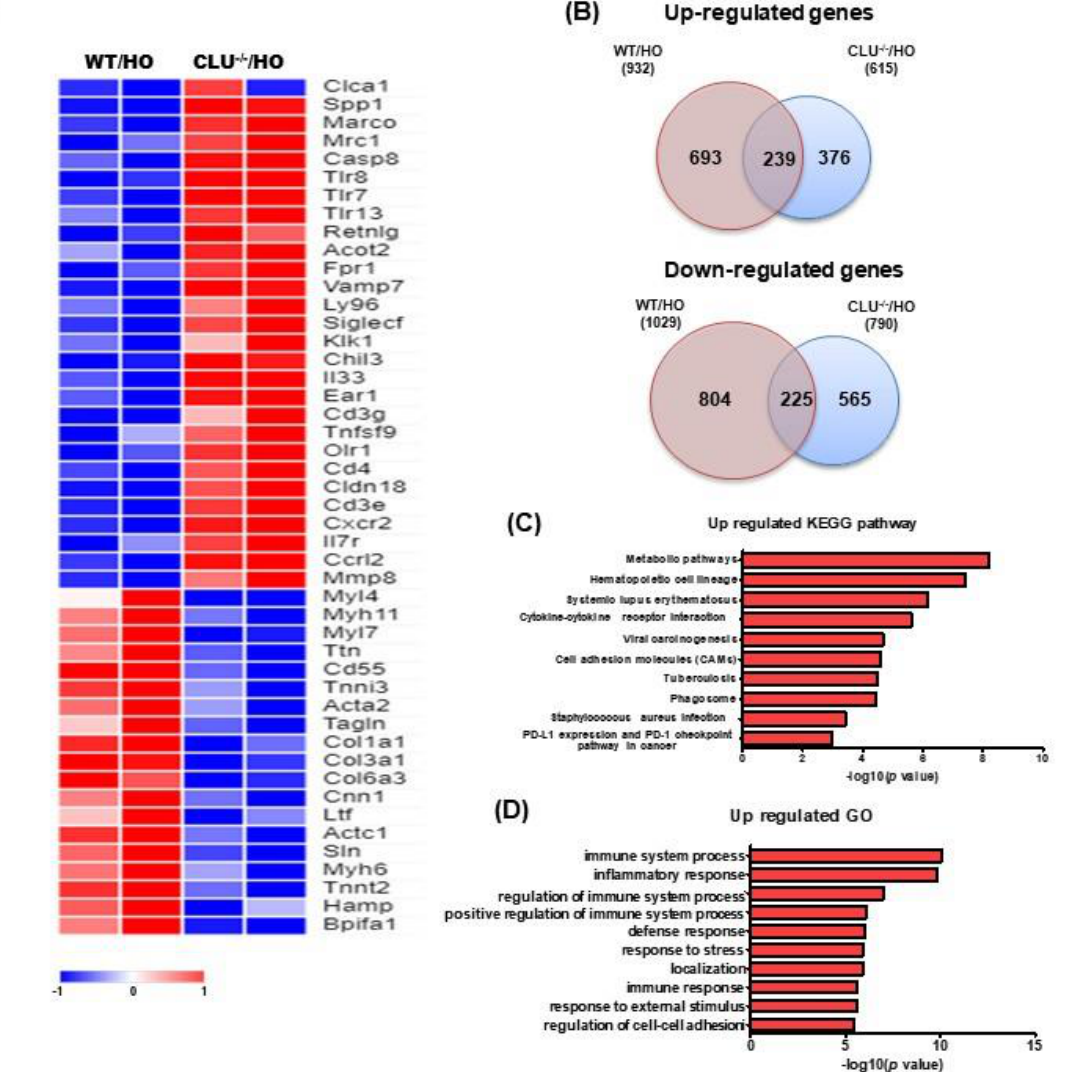
Figure 5. Microarray and pathway analysis of RNA from hyperoxia-induced acute lung injury. ( A ) Heat map representing differences in the expression of genes, as indicated. (WT/HO n = 2, CLU − / − /HO n = 2 animals per group) ( B ) Diagrams showing the number of upregulated and downregulated genes in WT and CLU − / − mice under hyperoxic conditions. ( C ) Kyoto Encyclopedia of Genes (KEGG) pathway and ( D ) Gene Ontology (GO) analyses of significant differentially expressed genes were conducted. The bars represent -log( p -value); the number of statistically significant genes is indicated in each category.